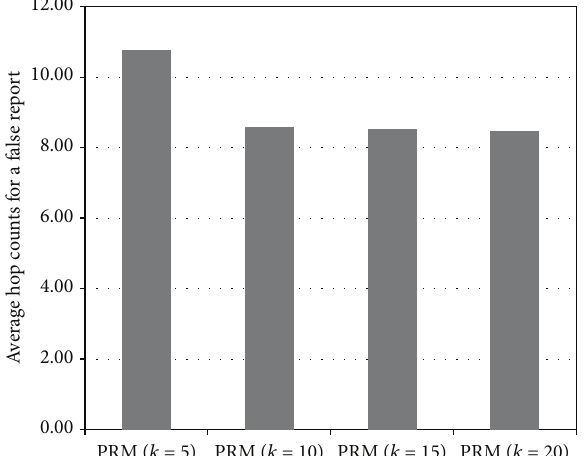
Figure 13: Average hop counts per false report for various 𝑘 values = 0.2) (𝛼 𝑃